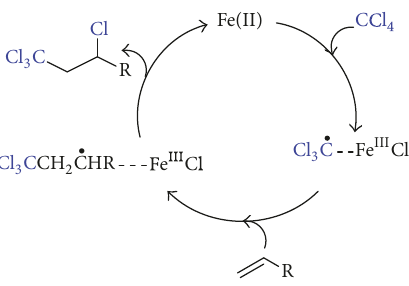
Scheme 1: Proposed mechanism for Kharasch addition of CCl 4 to olefins catalyzed by Fe(acac) 2